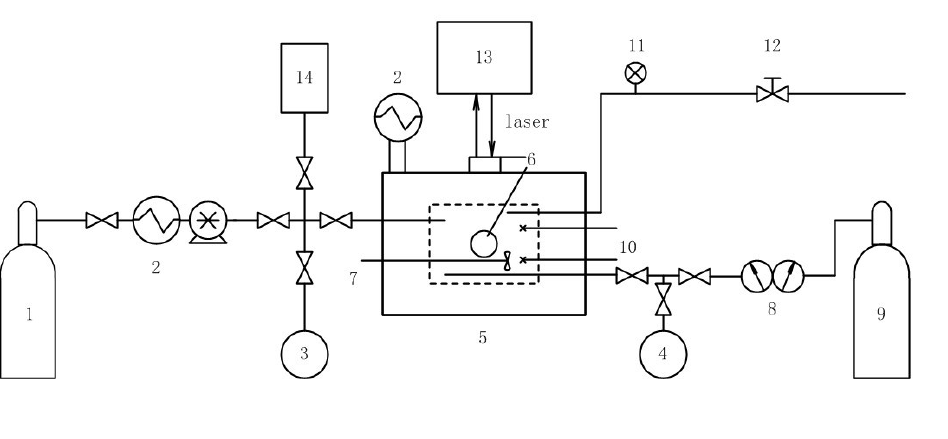
cylinder; 2: Cooler; 3: 2